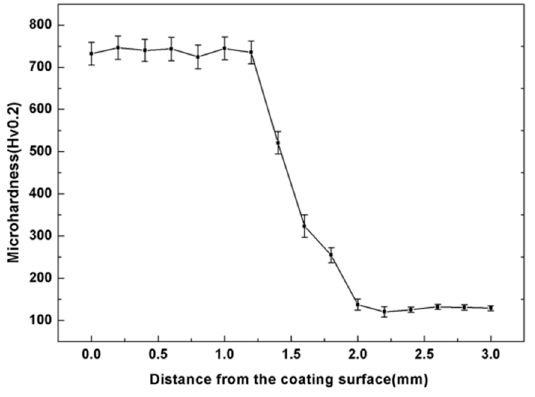
Figure 11. Cross-sectional microhardness profile of Ti/TiBCN composite coating.